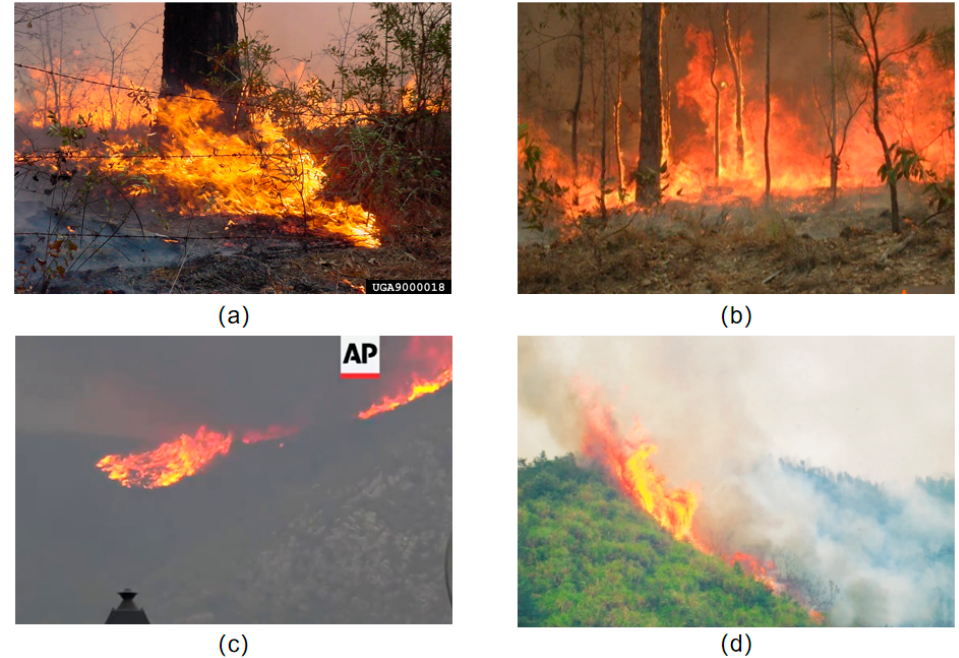
Figure 1. Representative forest fire images from the forest fire dataset: ( a ) ground fire, ( b ) canopy fire, ( c ) remote shot of a forest fire, and ( d ) remote shot of a forest fire.